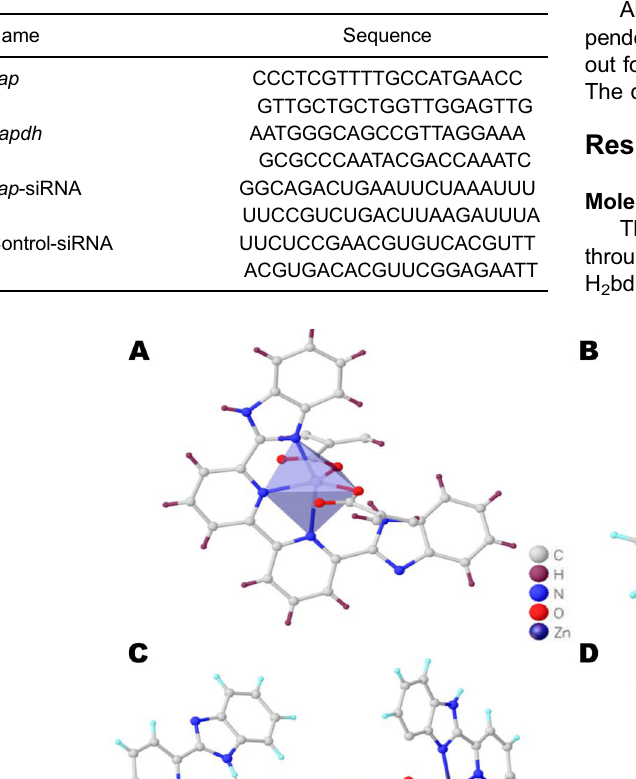
Table 2. Primers and si-RNA sequences.